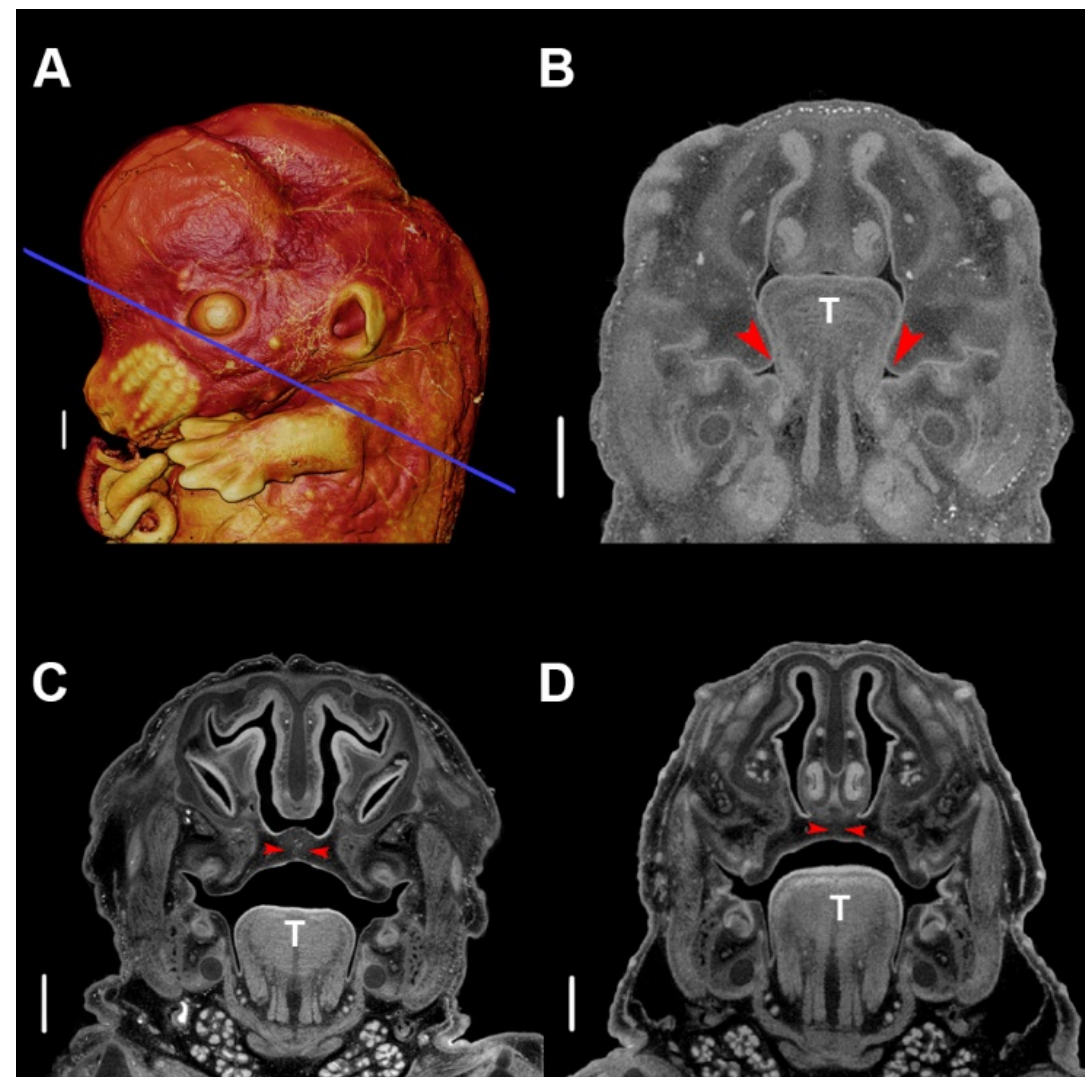
Figure 2. Typical palatogenesis in the murine embryo. ( A ) Three-dimensional (3D) volume-rendering of a phosphotungstic acid (PTA)-enhanced micro-computed tomography ( µ CT) image of an E13.5 embryo. The blue line indicates the slice plane for all stages. ( B ) Slice image of typical morphology at E13.5, depicting vertical palatal shelves. ( C ) Slice image of typical morphology at E14.5, depicting abutting palatal shelves beginning fusion at the midline. ( D ) Slice of typical morphology at E15.5, depicting fully fused palatal shelves at the midline. The red arrowhead indicates the location of palatal shelves, and T indicates the tongue. Scale bars are 500 µ m. Specimens were stained with phosphotungstic